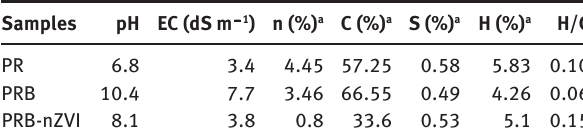
Table 1: Selected chemical composition of PR, PBR, and PBR-nZVI.